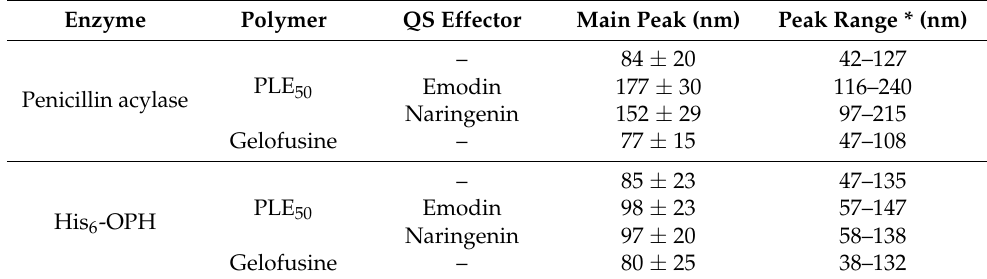
Table 2. Calculated hydrodynamic sizes of main fractions of various enzyme NCs.